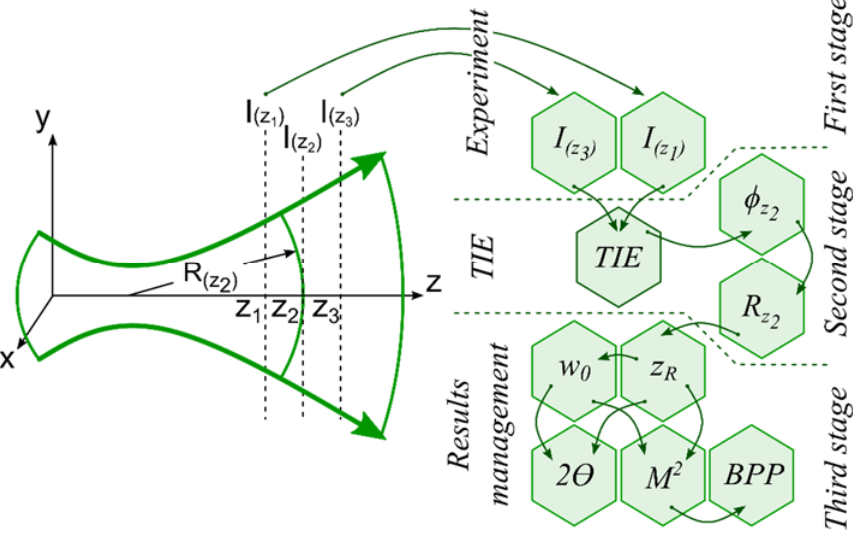
Figure 2. Schematic of the experimental measurements and algorithm for calculating the spatial parameters of the laser beam.